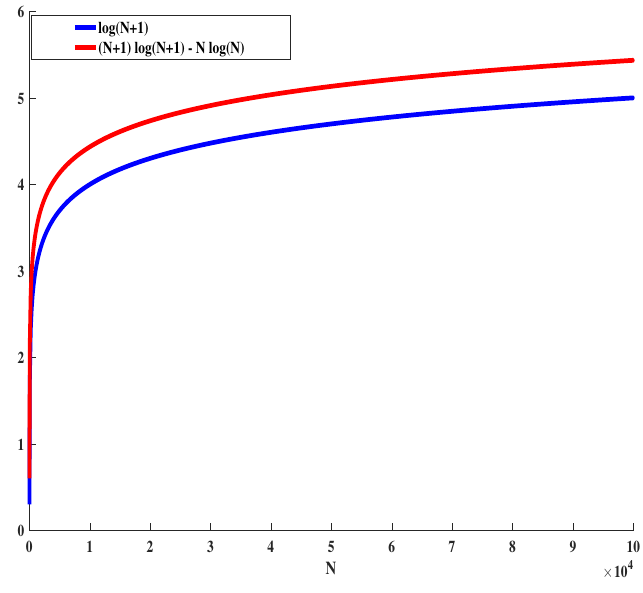
Figure 4. Similarity between UE’s utility and BS’s